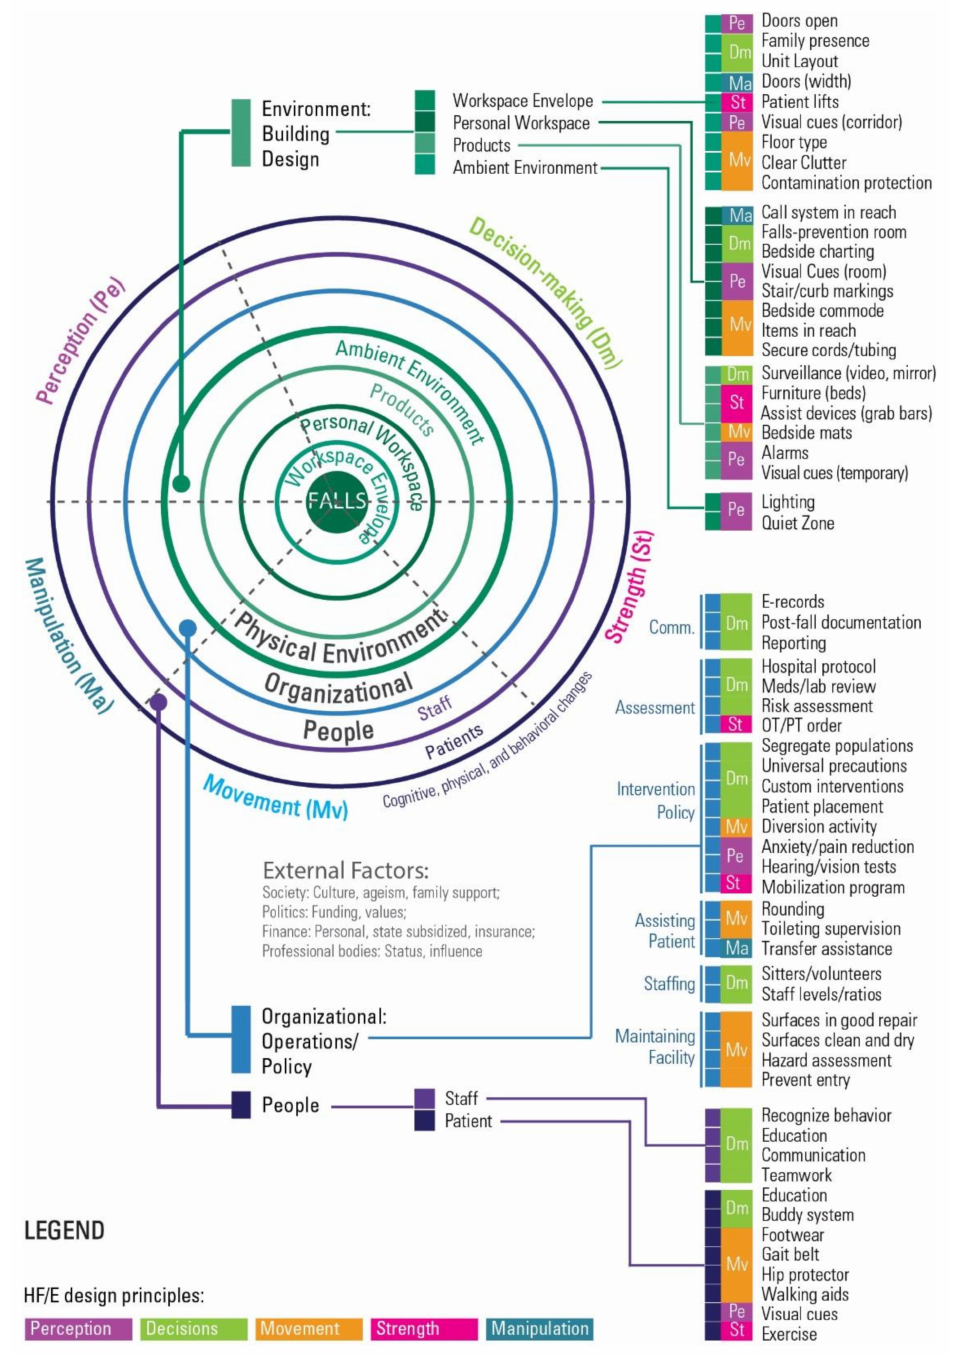
Figure 1. DEEP SCOPE: Designing with Ergonomic principles—Expansion of the SCOPE model (Safety = Complexity * (Organization + People + Environment))